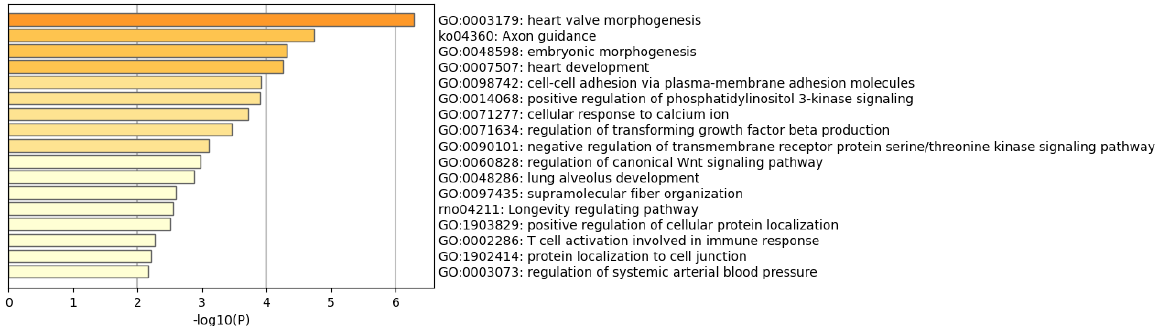
Figure 4. Enrichment results of the selected 64 down-regulated DEG comparing WTC vs. ISO. Functional gene set enrichment analysis was performed on the 64 DEGs that were down-regulated in WTC compared with ISO group at both day 360 (with p < 0.05) and day 240 (with p < 0.1).